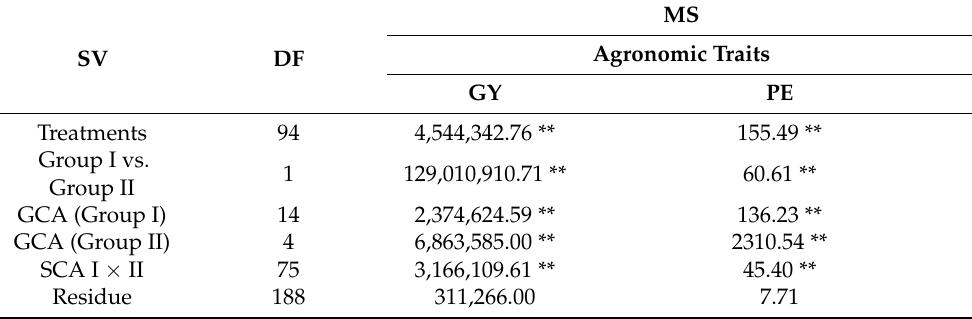
Table 2. Mean squares estimates (parents and F 1 (cid:48) s ) of general (GCA) and specific combining abil- ity (SCA) and experimental residue for evaluated agronomic traits and incidence and severity of P. polysora , B. maydis, and E. turcicun